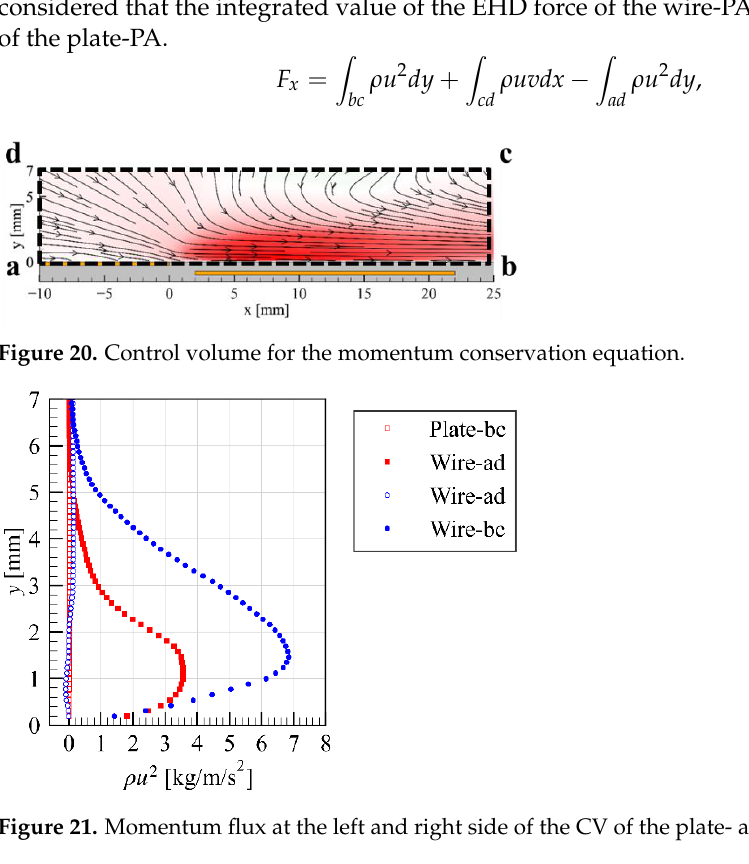
Figure 21. Momentum flux at the left and right side of the CV of the plate- and wire-PA.